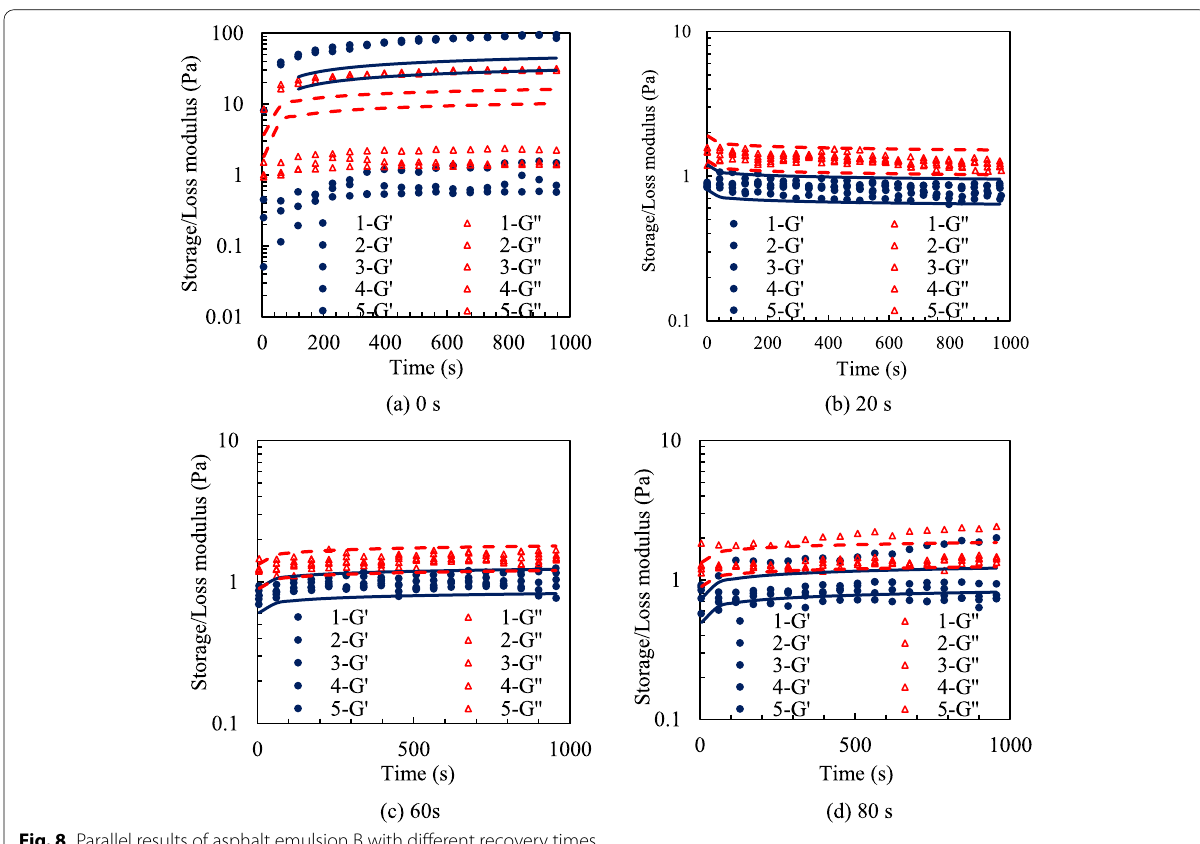
Fig. 8 Parallel results of asphalt emulsion B with different recovery times